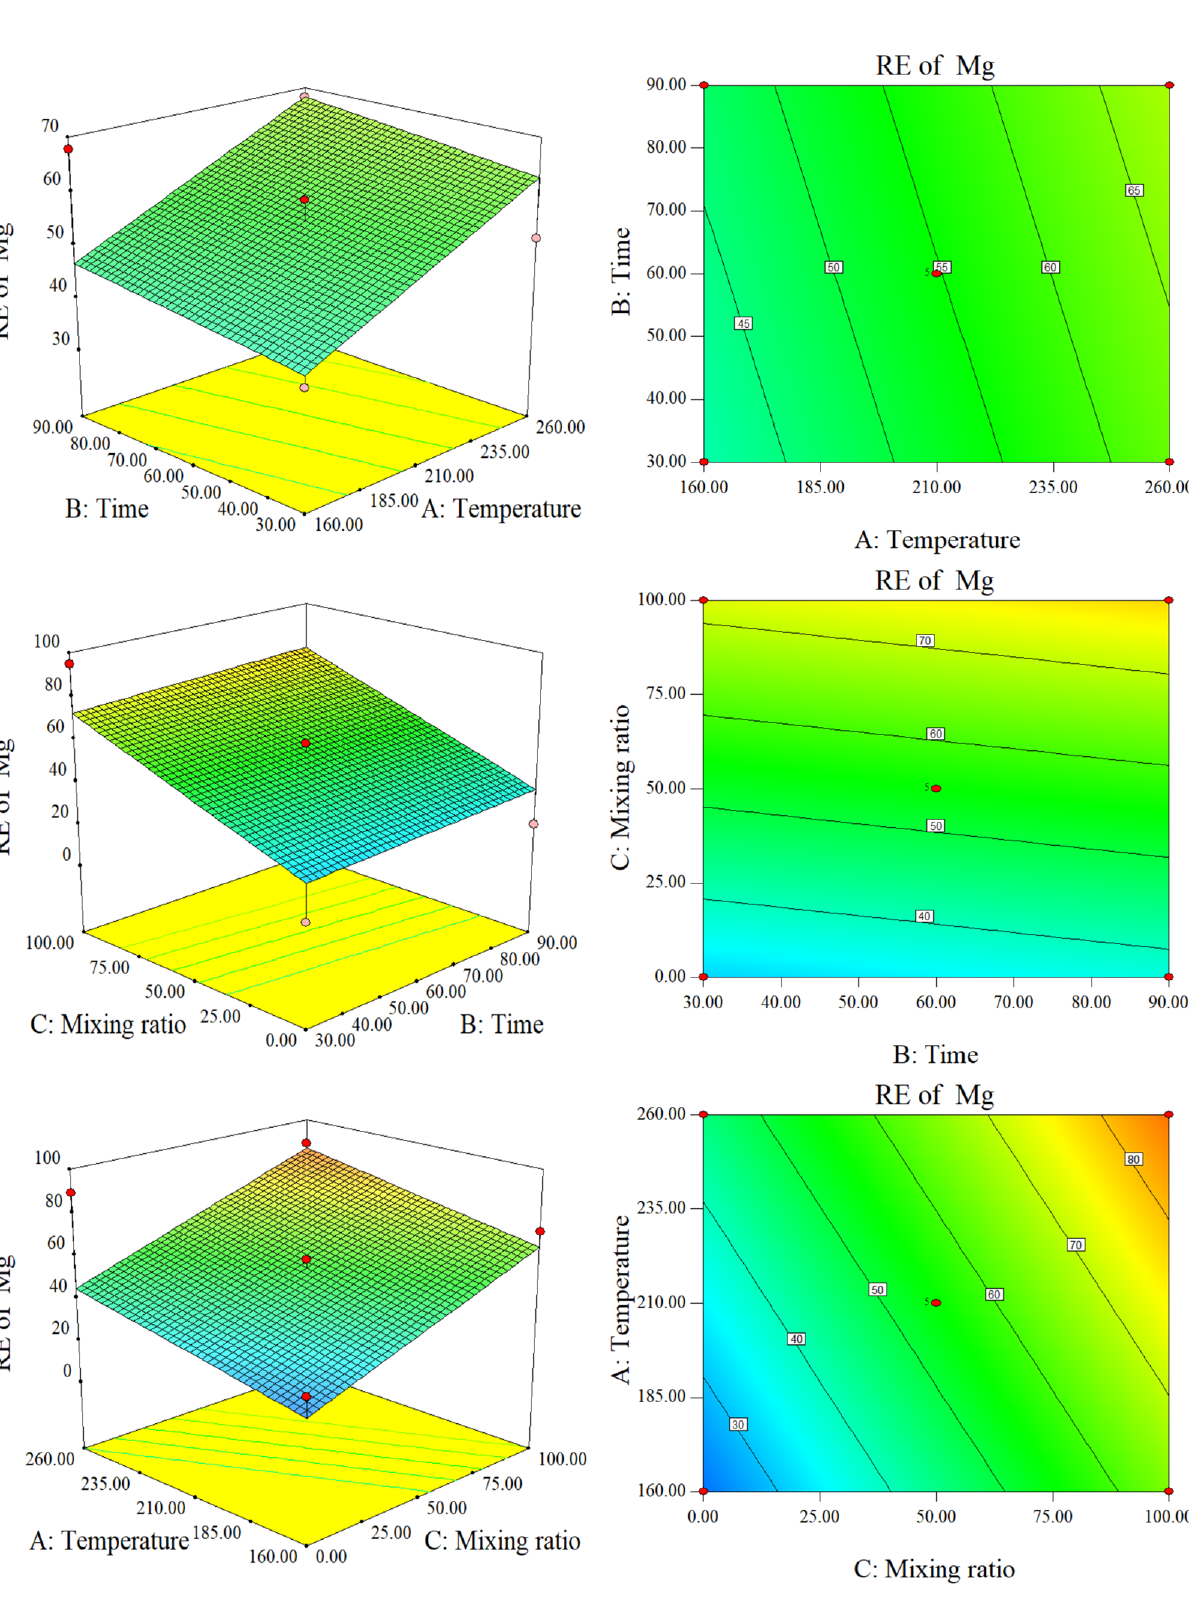
Figure 7. Response surface plots and contour plots of the RE of Mg.